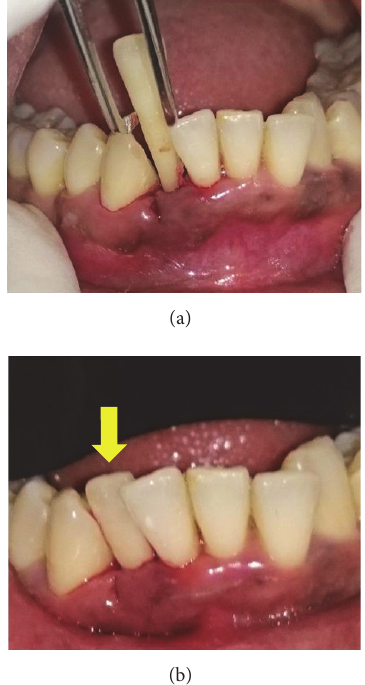
Figure 3: (a) Extraction of 42. (b) NTP with respect to